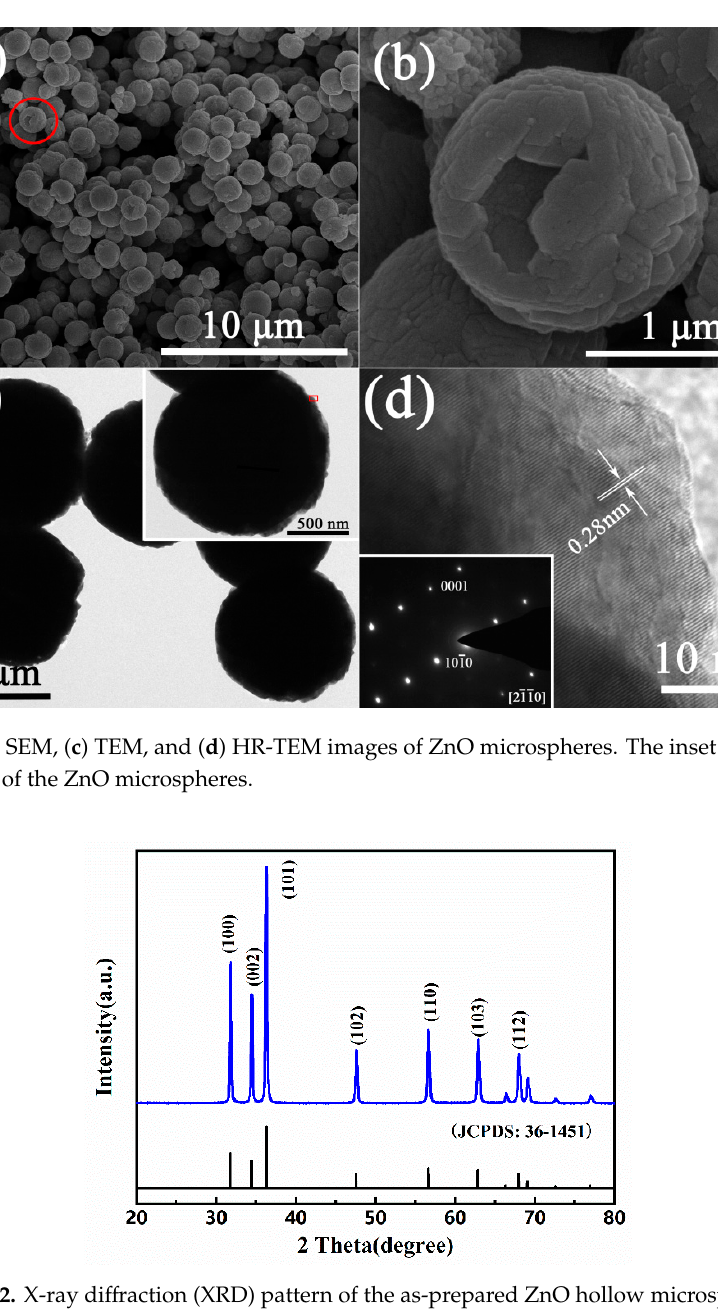
Figure 2. X-ray diffraction (XRD) pattern of the as-prepared ZnO hollow microspheres.